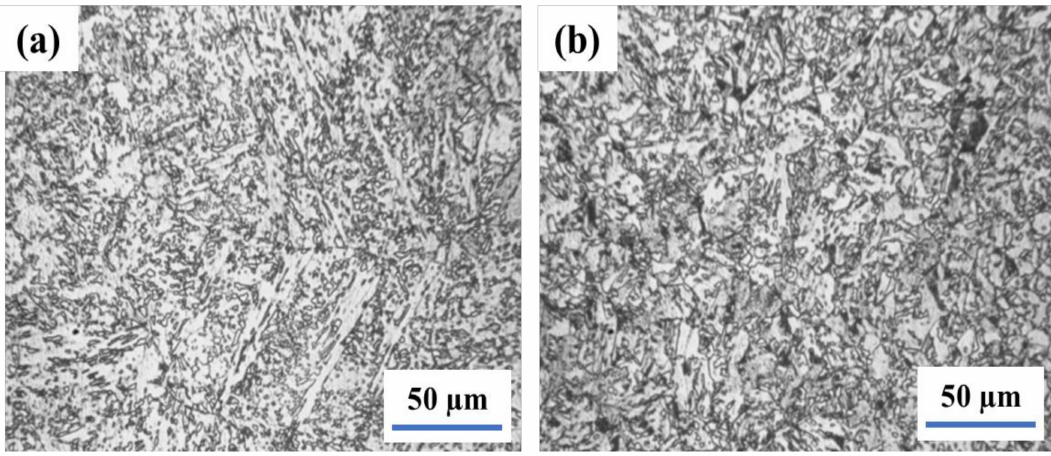
Figure 2. The Microstructure of weld joint after simulation hot stamping − weld ( a ) and HAZ ( b ). The microstructure of the welding joint, which was normalized at 920 ◦ C for 1 h after the hot stamping forming simulation, is depicted in Figure 3. After that, the bainite ferrite in the weld became equiaxial. In the HAZ, the shape of bainite ferrite was transformed into the strip. However, the morphology of the M-A constituents is not significantly changed.